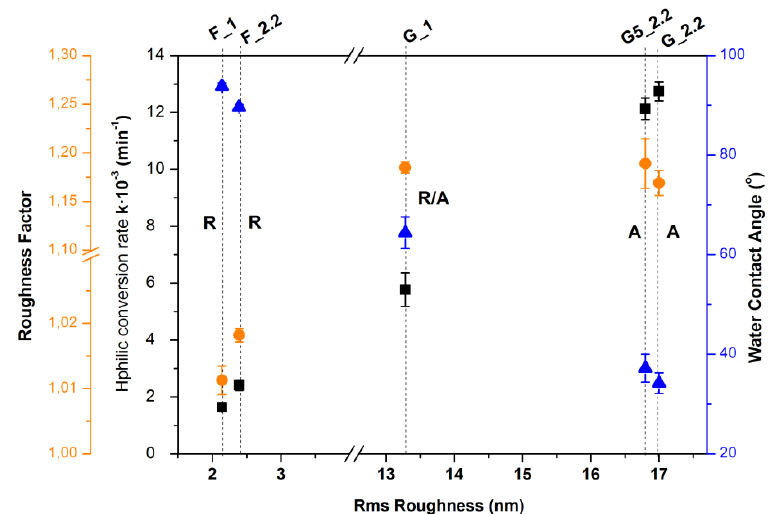
Table 2. The TiO 2 thin films surface properties (RMS roughness and roughness factor), hydrophilic conversion rate, water contact angle (WCA) and their corresponding crystalline phase.